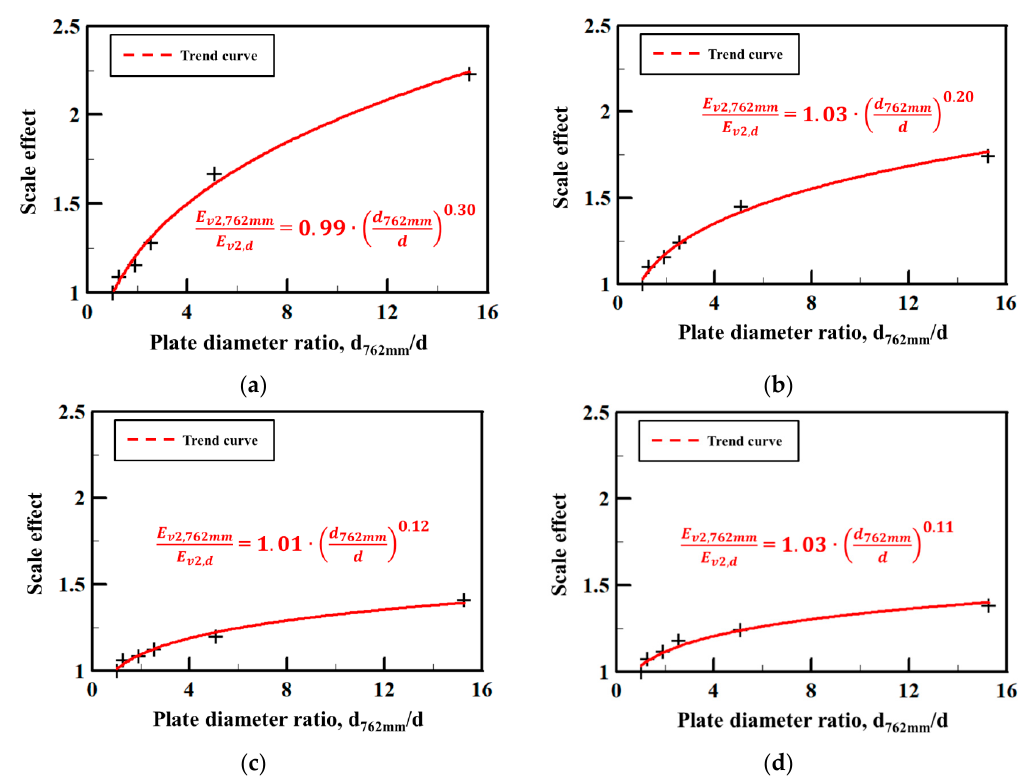
Figure 7. Scale effect normalized to the reference loading plate of the repetitive plate-loading test (762 mm): ( a ) gravel and fine gravel; ( b ) sand; ( c ) sandy soil; ( d ) cohesive